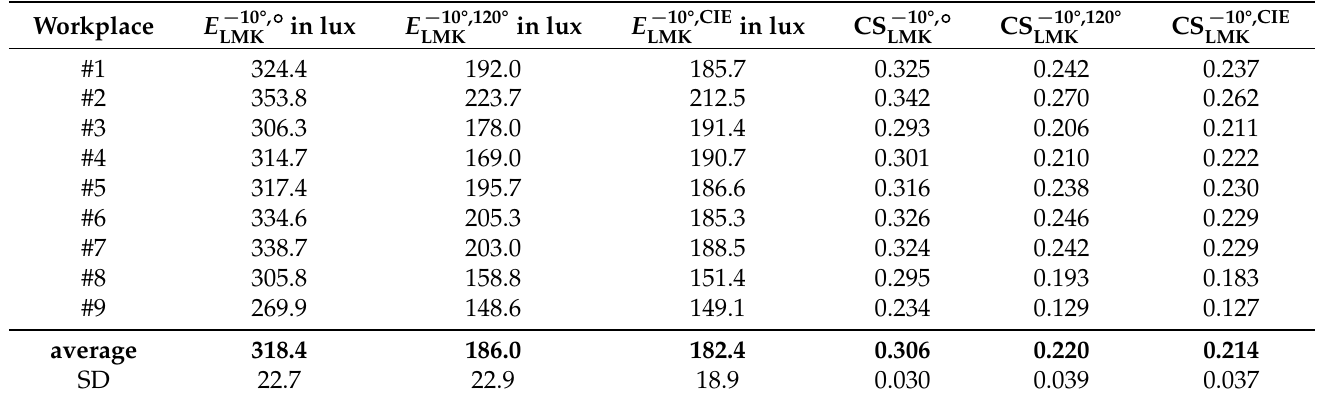
Table 3. Comparison of the illuminance and CS values calculated from the spatially resolved light measurements for the different FOV definitions and a non-zero tilt angle α = −